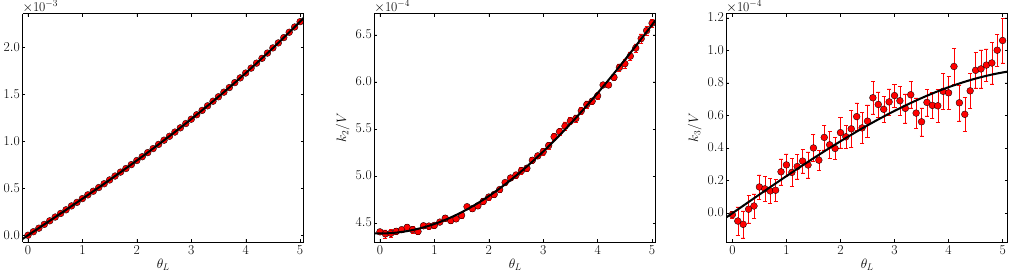
Figure 4 . Example of the θ L -dependence of the first three cumulants, along with best fits obtained expanding f ( θ ) up to sixth order. Data refers to the case N = 21, β L = 0 . 66 on a square lattice with L = 72. In this figure correlations among measures at different θ L introduced by the simulated tempering are